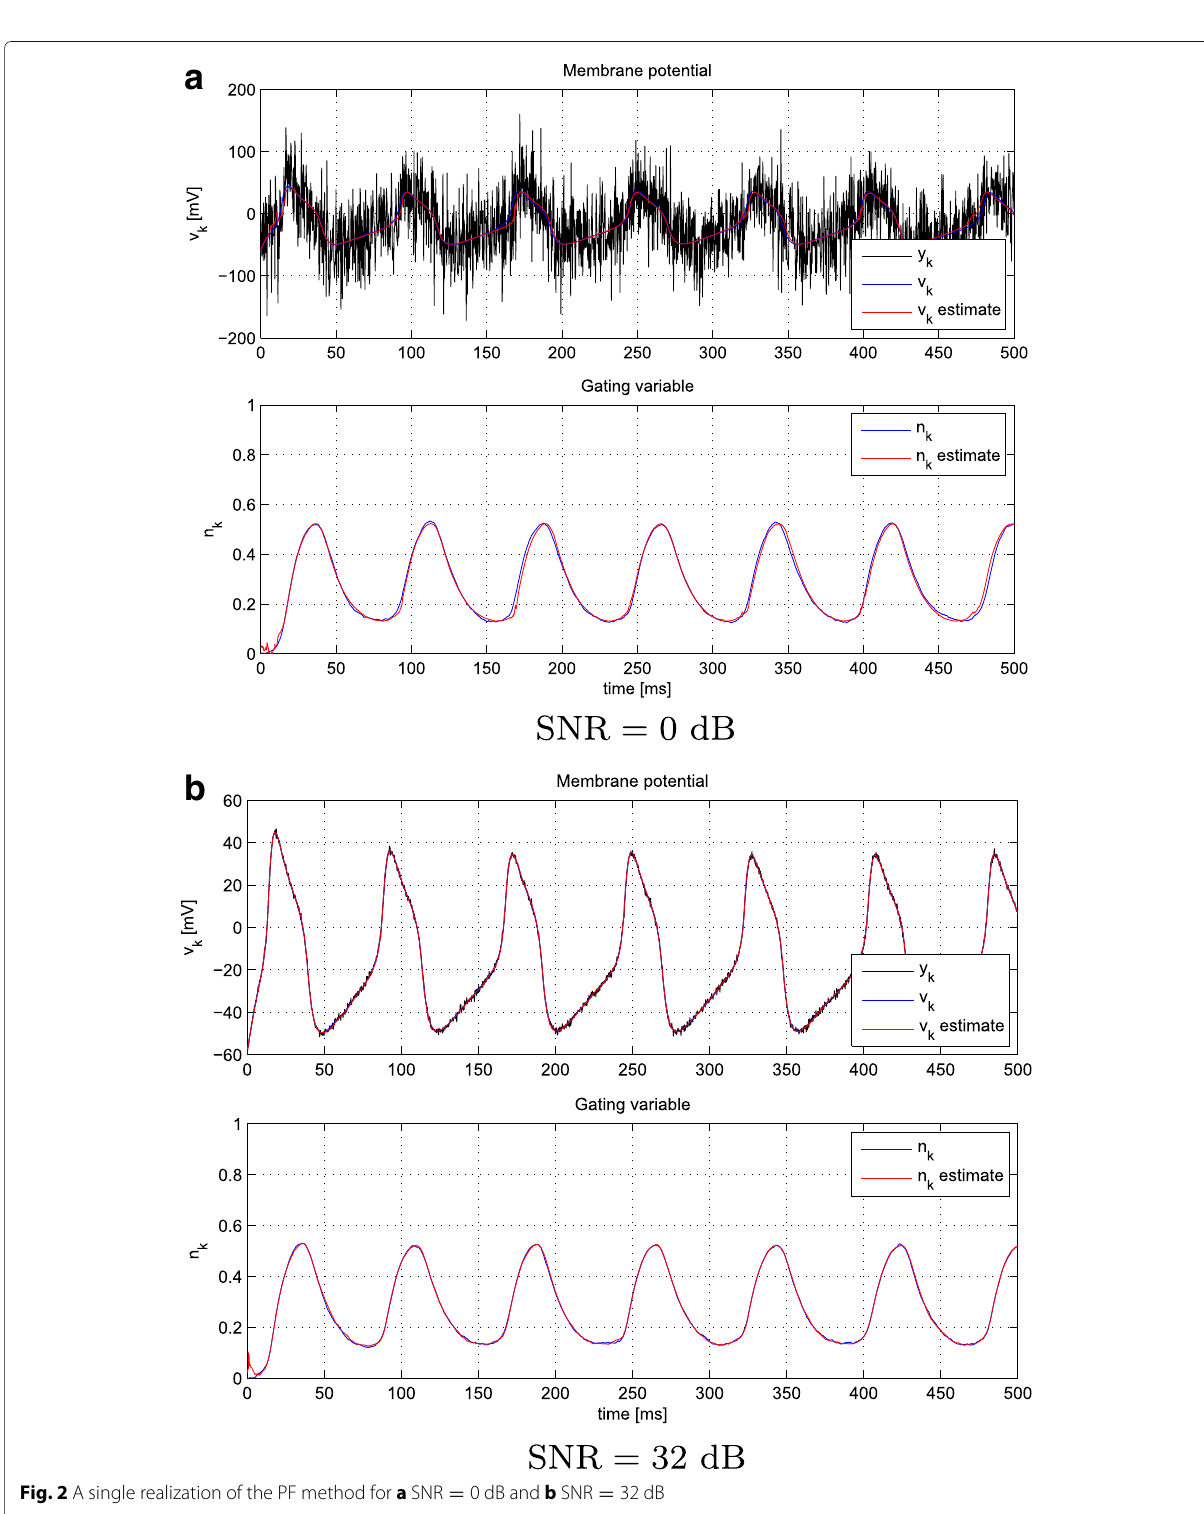
Fig. 2 A single realization of the PF method for a SNR = 0 dB and b SNR = 32 dB